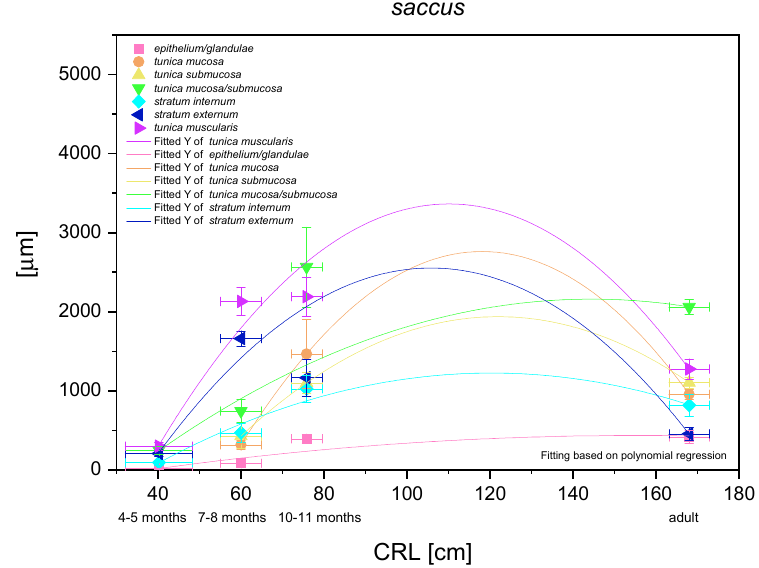
Figure 14. Histometric analysis of the stomach wall structures in the blind ventricular sac (saccus). The figure shows nonlinear regression curves of all metric parameters in all three age groups and adult reference group.